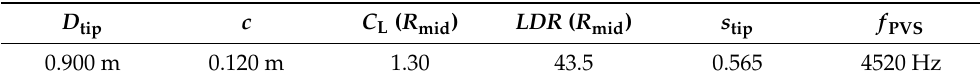
Table 5. PVS frequency for a five-bladed, n = 1450 1/min axial flow